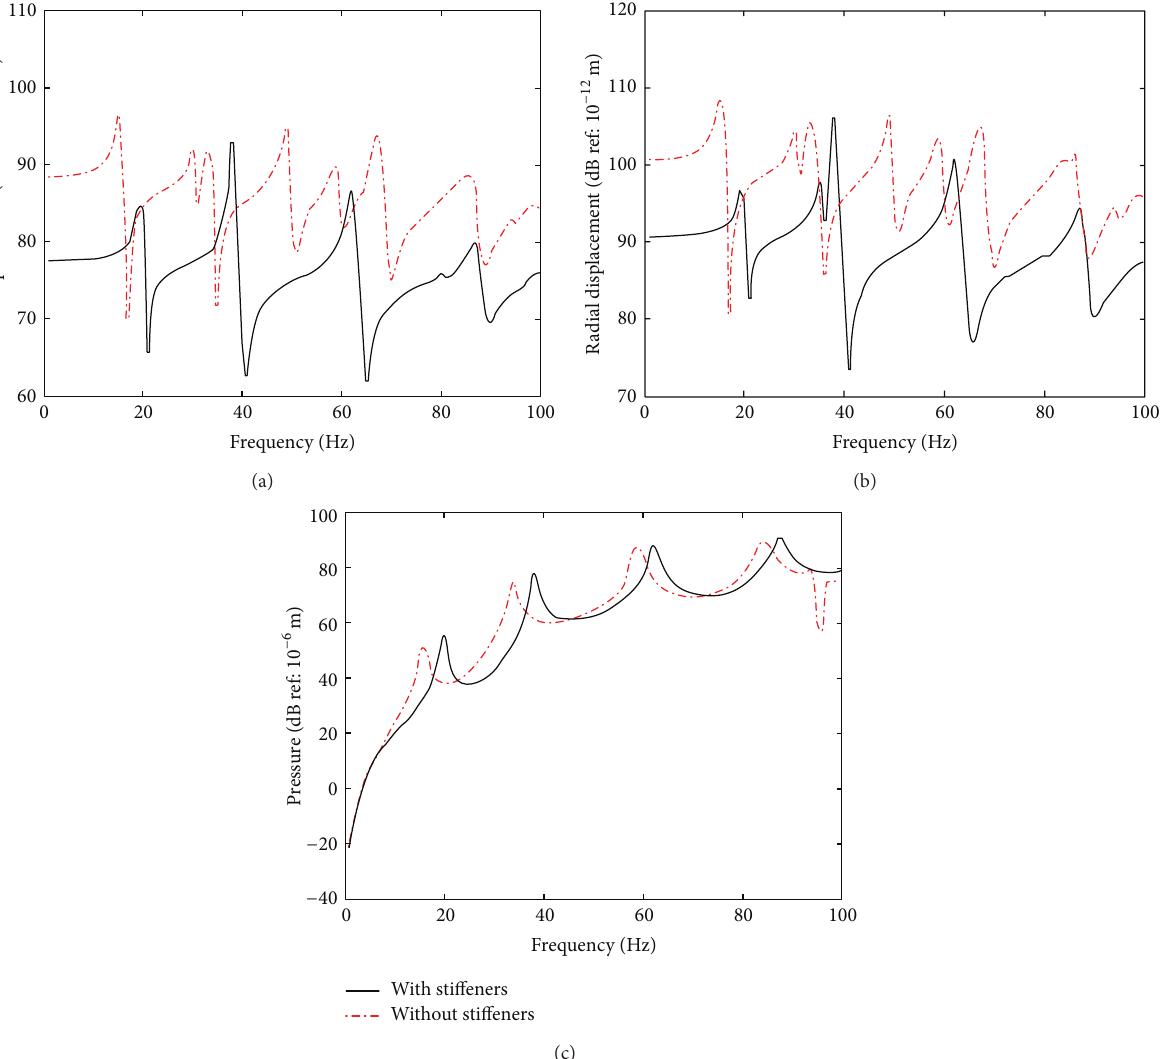
Figure 14: Comparison of conical shells with and without stiffeners, under 𝐹 2 (a) axial displacement, (b) radial displacement, and (c) far-field